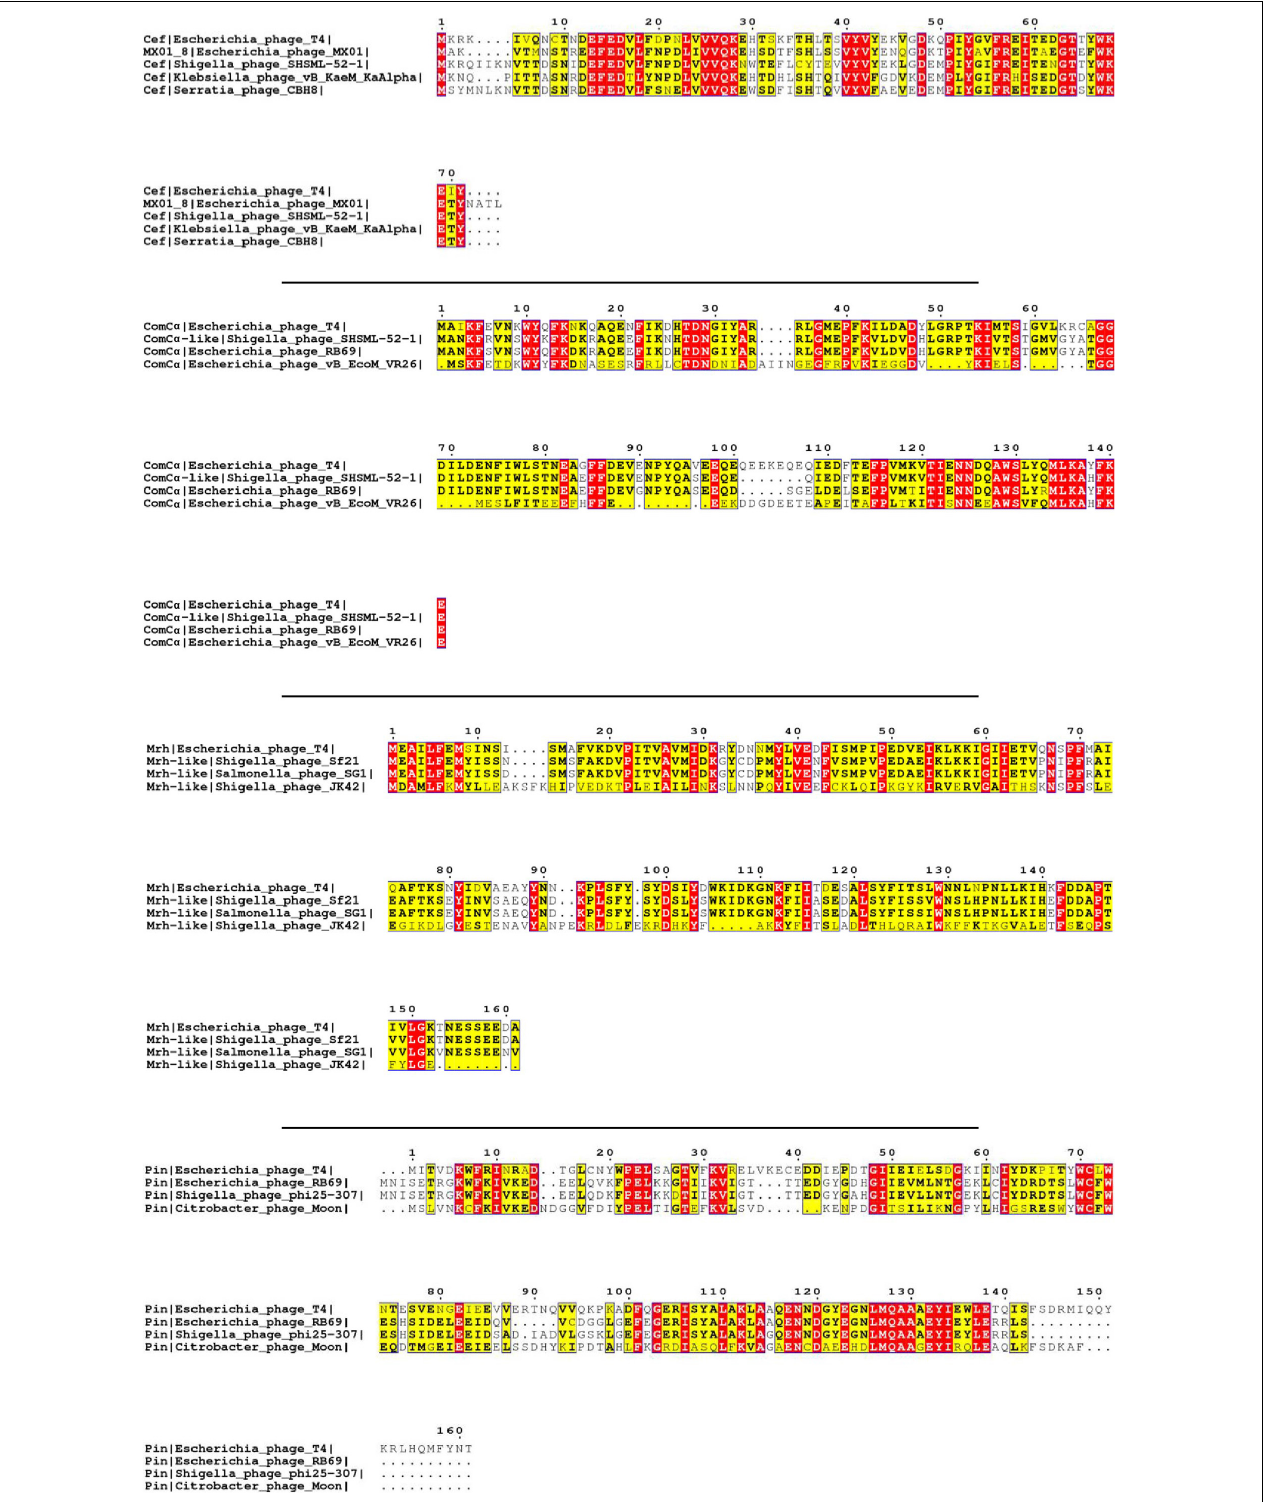
FIGURE 1 | Multiple sequence alignment of selected T4 proteins. The multiple sequence alignments of Cef, ComC α , Mrh, and Pin of T4 showing the conserved regions of each viral protein with that of other phages. The purification and characterization of these proteins could provide a solid basis for future studies on these homologs of other phages. The red and yellow color is the visualization of “*,” which represents the fully conserved amino acid amongst all the sequences, and “:,” which represents amino acids with high similarities amongst the sequences ( > 0.5 in the Gonnet Pam 250 Matrix) used in the ClusterW alignment format.